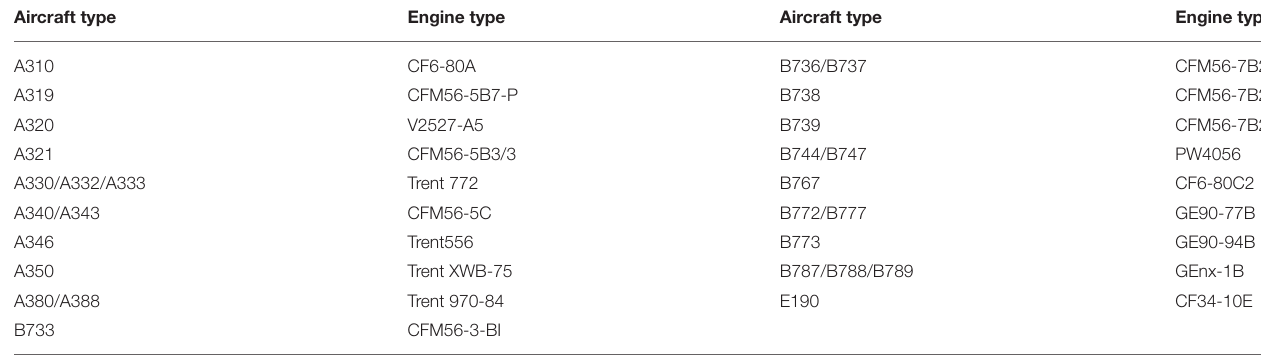
TABLE 2 | The combination of Aircraft/Engine for